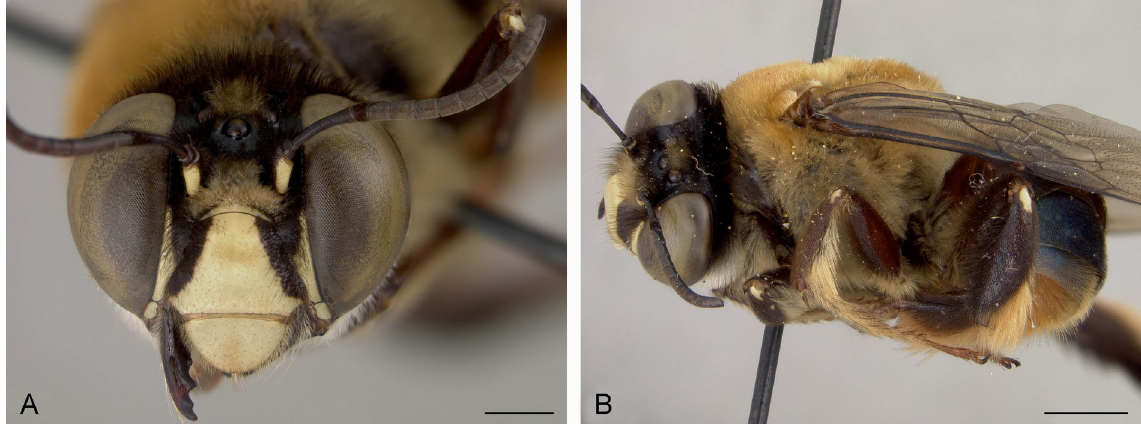
Fig. 8. Centris versicolor vincentana Cockerell, 1938, holotype, ♂ (NMNH; USNM ENT 00534218). A . Frontal view. B . Habitus, lateral view. Scale bars: A = 1 mm; B = 2